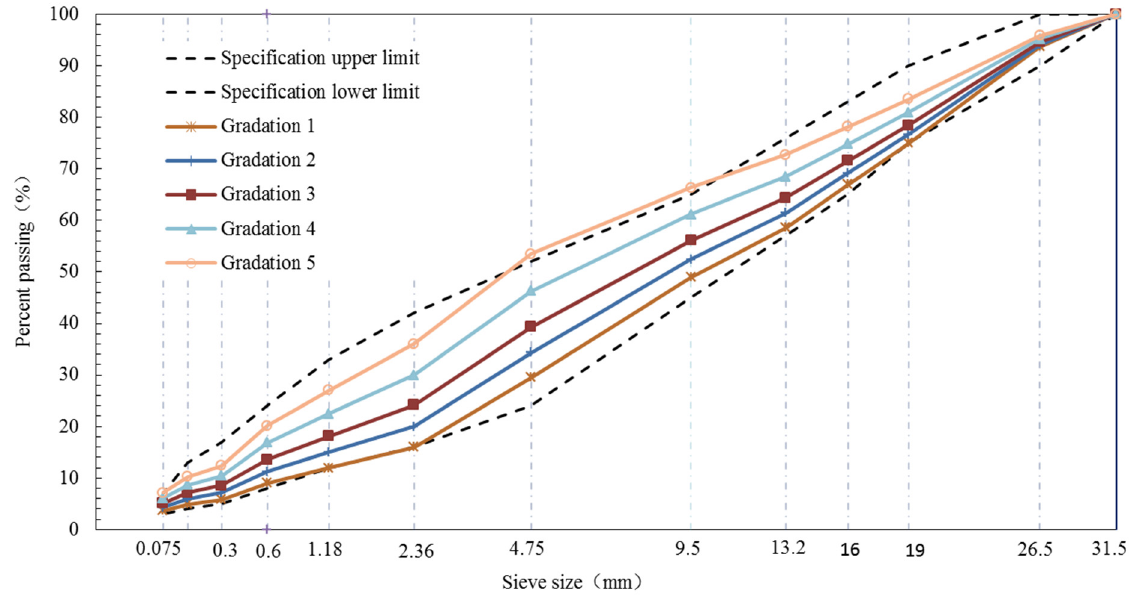
Figure 3. Gradation curves of AC-25.